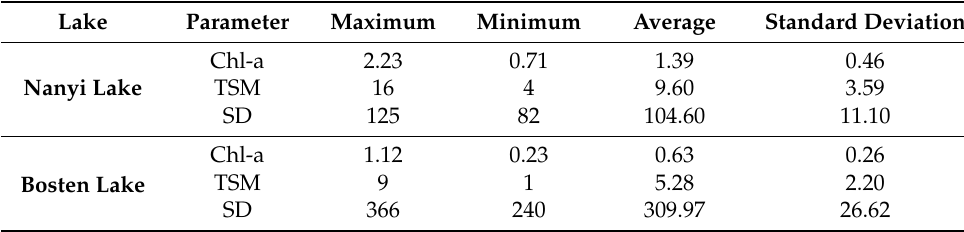
Table 2. In-situ data information statistics